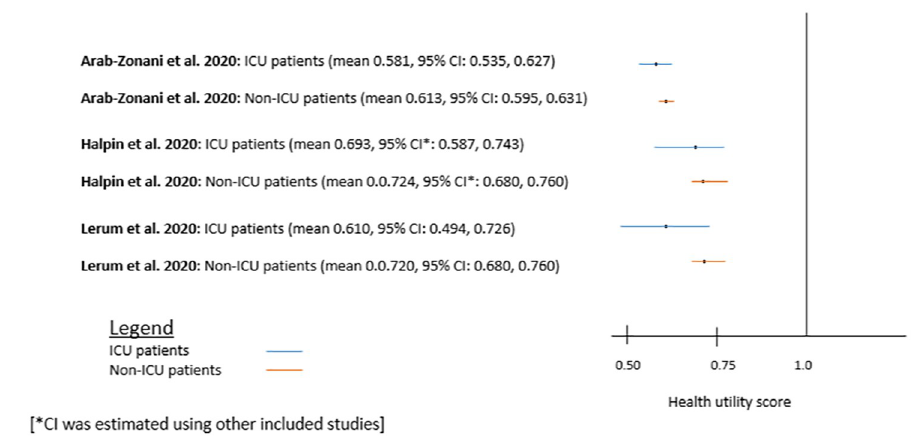
Fig 4. Mean EQ-5D-5L scores for ICU and non-ICU patients reported in different studies.